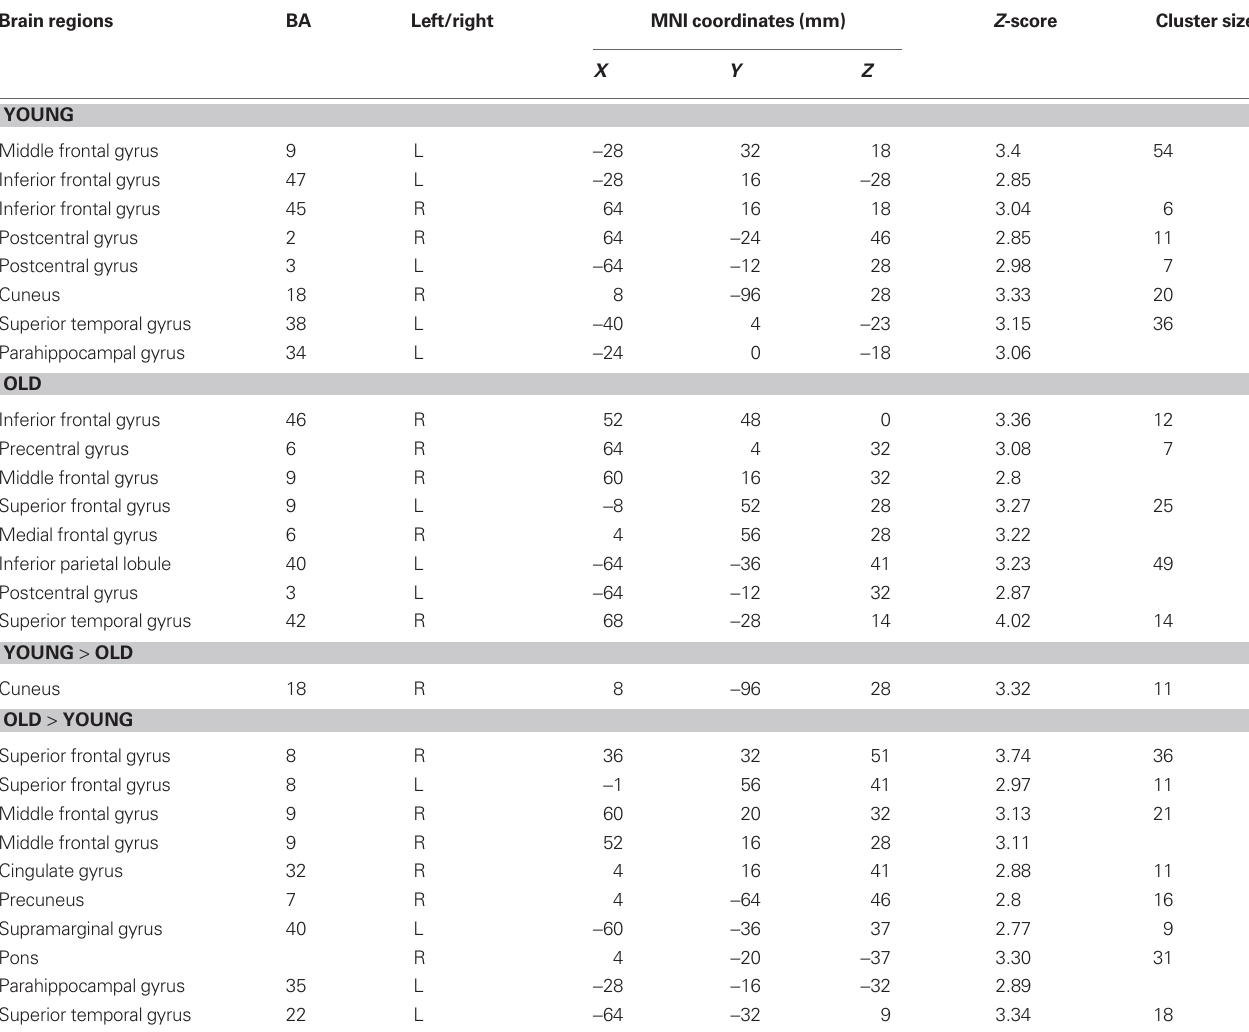
FIGURE 2 | Interaction of learning stage and age in VST in reward processing. (A) Increased activity in bilateral VST in reward processing comparing “learned” trials relative to “search” trials in younger adults Table 5 | Decision making during “learned” vs. “search”